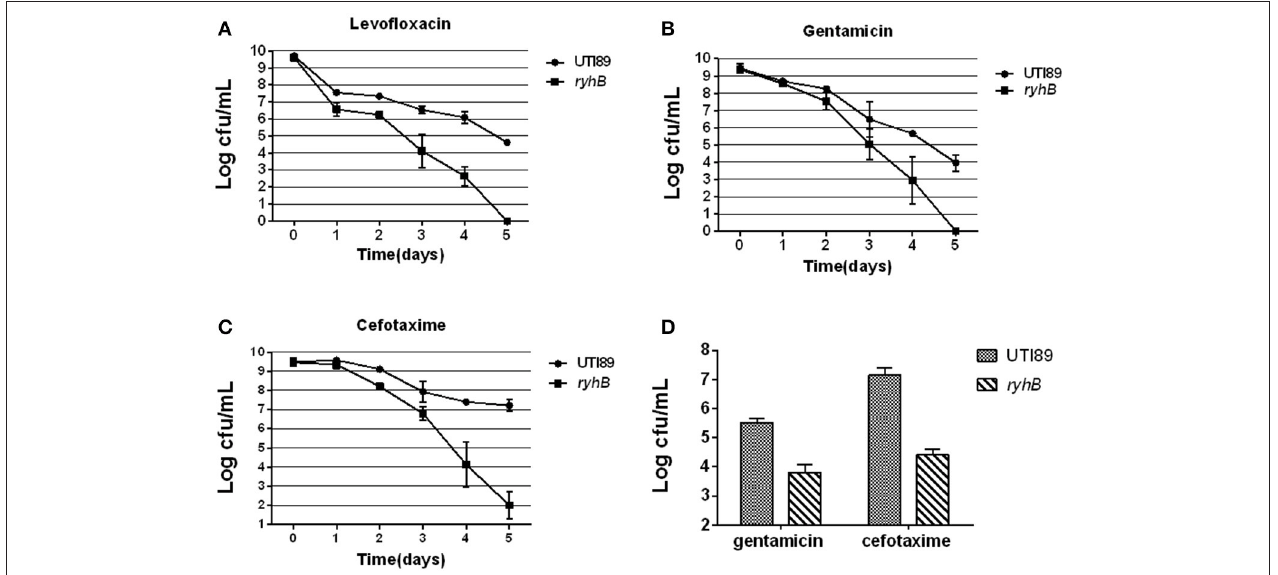
FIGURE 1 | Susceptibilities of the 1 ryhB mutant to a variety of antibiotics. (A–C). Susceptibilities of the stationary phase bacteria ( ∼ 10 9 CFU/mL) were determined every day after exposure to levofloxacin (5 µ g/mL, A ), gentamicin (30 µ g/mL, B ) or cefotaxime (128 µ g/mL, C ). (D) Susceptibilities of the exponential phase bacteria